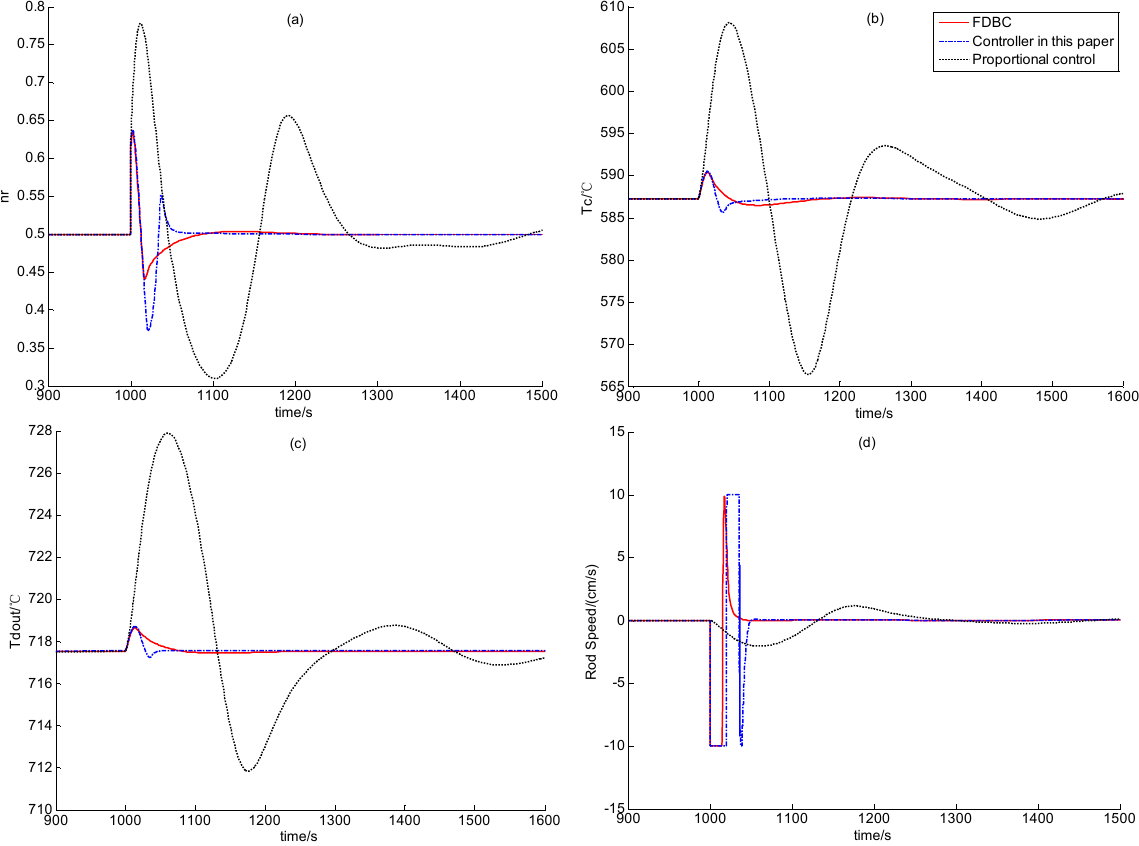
Figure 6. Simulation Results in Case